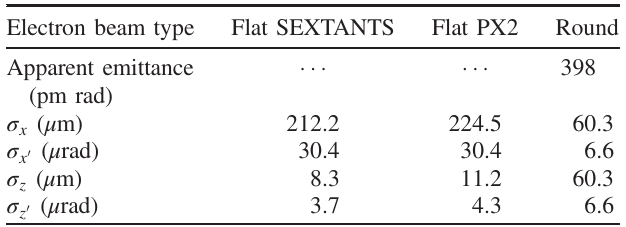
TABLE I. Electron beam size configurations used in the